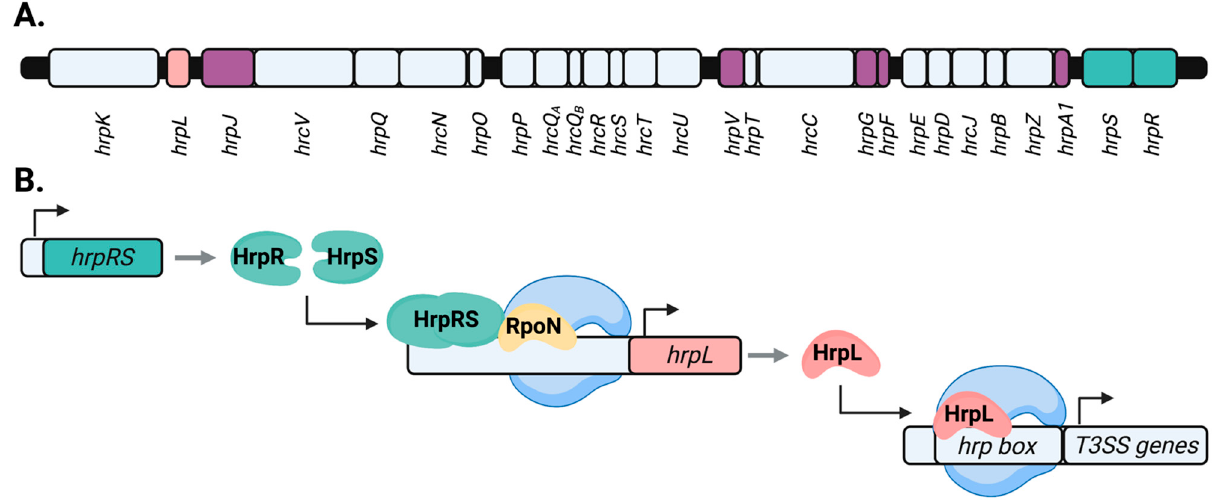
Figure 1. Regulation of the T3SS by components of the hrp/hrc pathogenicity cluster in P. syringae . ( A ) Depicted is a schematic of the hrp/hrc pathogenicity cluster within the tripartite T3SS pathogenicity island in P. syringae pv. syringae 61. This schematic is adapted from Alfano et al., 2000 [34]. Colored boxes depict open reading frames, with corresponding hrp/hrc gene names listed below. Genes encoding T3SS master regulators HrpL and HrpRS are shaded in coral and teal, respectively. Shaded in violet are additional regulators of T3SS expression that function at either the transcriptional or post-transcriptional level. ( B ) Depicted is a diagram of the T3SS regulatory cascade in P. syringae . Genes encoding the regulatory proteins HrpR and HrpS (teal) are transcribed from the hrpRS operon within the hrp/hrc pathogenicity cluster. HrpRS oligomerize (depicted as a dimer for clarity) and bind the hrpL promoter. Together with alternate sigma factor RpoN (gold), which recruits RNA polymerase (blue) to the hrpL promoter, HrpRS stimulate transcription of hrpL . HrpL (coral) functions as an alternate sigma factor to recruit RNA polymerase to a conserved binding motif, termed the “hrp box,” in the promoters of target genes. By this mechanism, HrpL directs the transcription of downstream genes, including T3SS-associated genes. Figure was made using BioRender (https://app.biorender.com, accessed on 30 April2021).